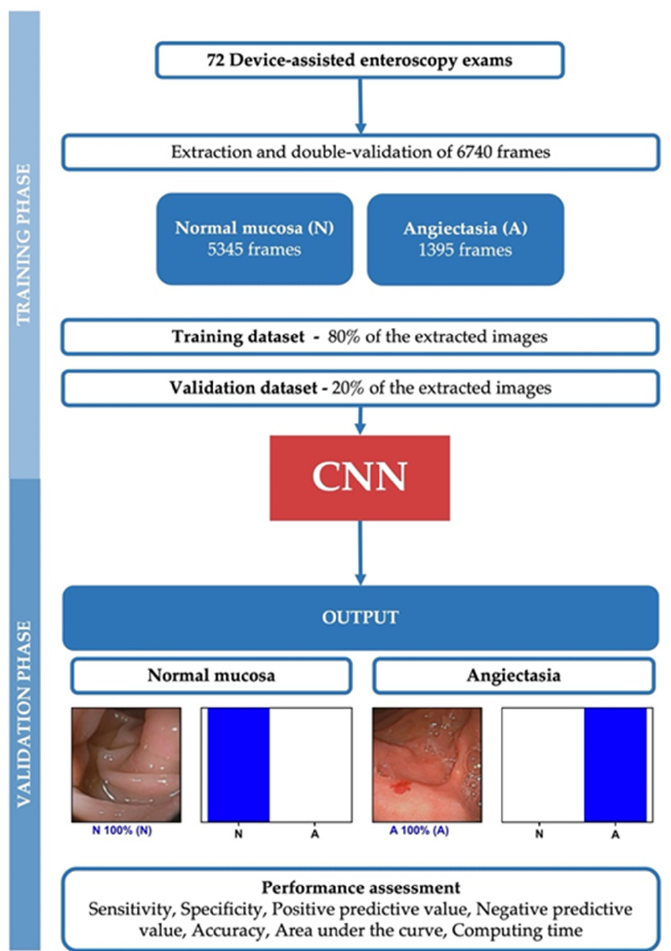
Figure 1. Study flowchart for the training and validation phases. AUC—area under the receiving operator characteristic curve; N—Normal mucosa; A—Angioectasia.